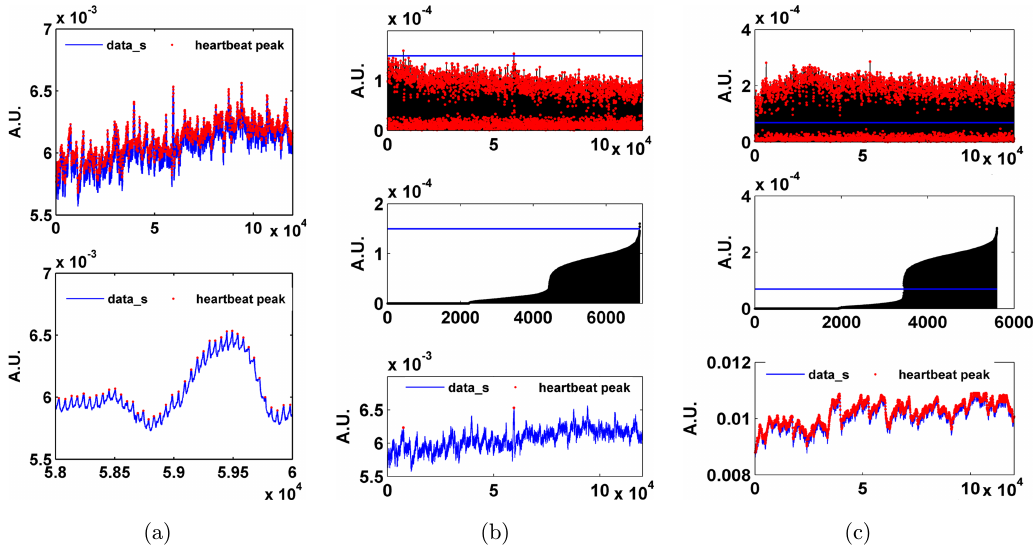
Fig. 5. Comparison between our method and the previous MMM. (a) Heartbeat peaks detected by our method, and the enlarged plot of the corresponding period in the bottom subgraph. (b) Heartbeat peaks obtained by MMM. The top subgraph shows all peaks of waves containing a width smaller M in data s m . The middle subgraph shows all peaks in ascending order of amplitude. The blue line in these two subgraphs indicates the threshold. The optical data in (a) and (b) are from Sub3 Ch6 a . (c) Heartbeat peaks obtained by MMM for another data from Sub1 Ch2 b